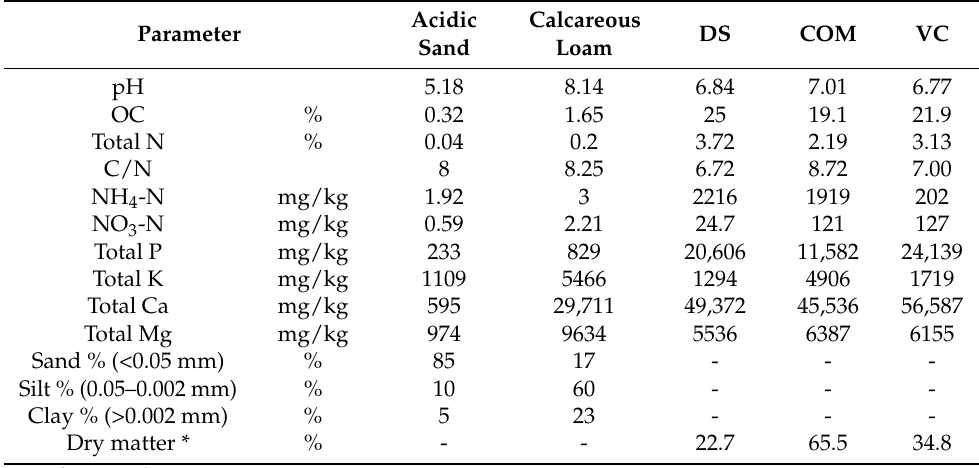
Table 1. Chemical properties of the soils, digested sludge (DS), compost (COM), and vermicompost (VC). Values are given in terms of dry matter.